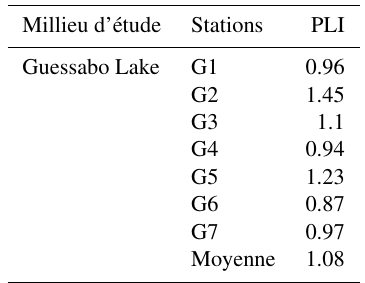
Tableau 4. Valeurs moyennes du PLI des sédiments par